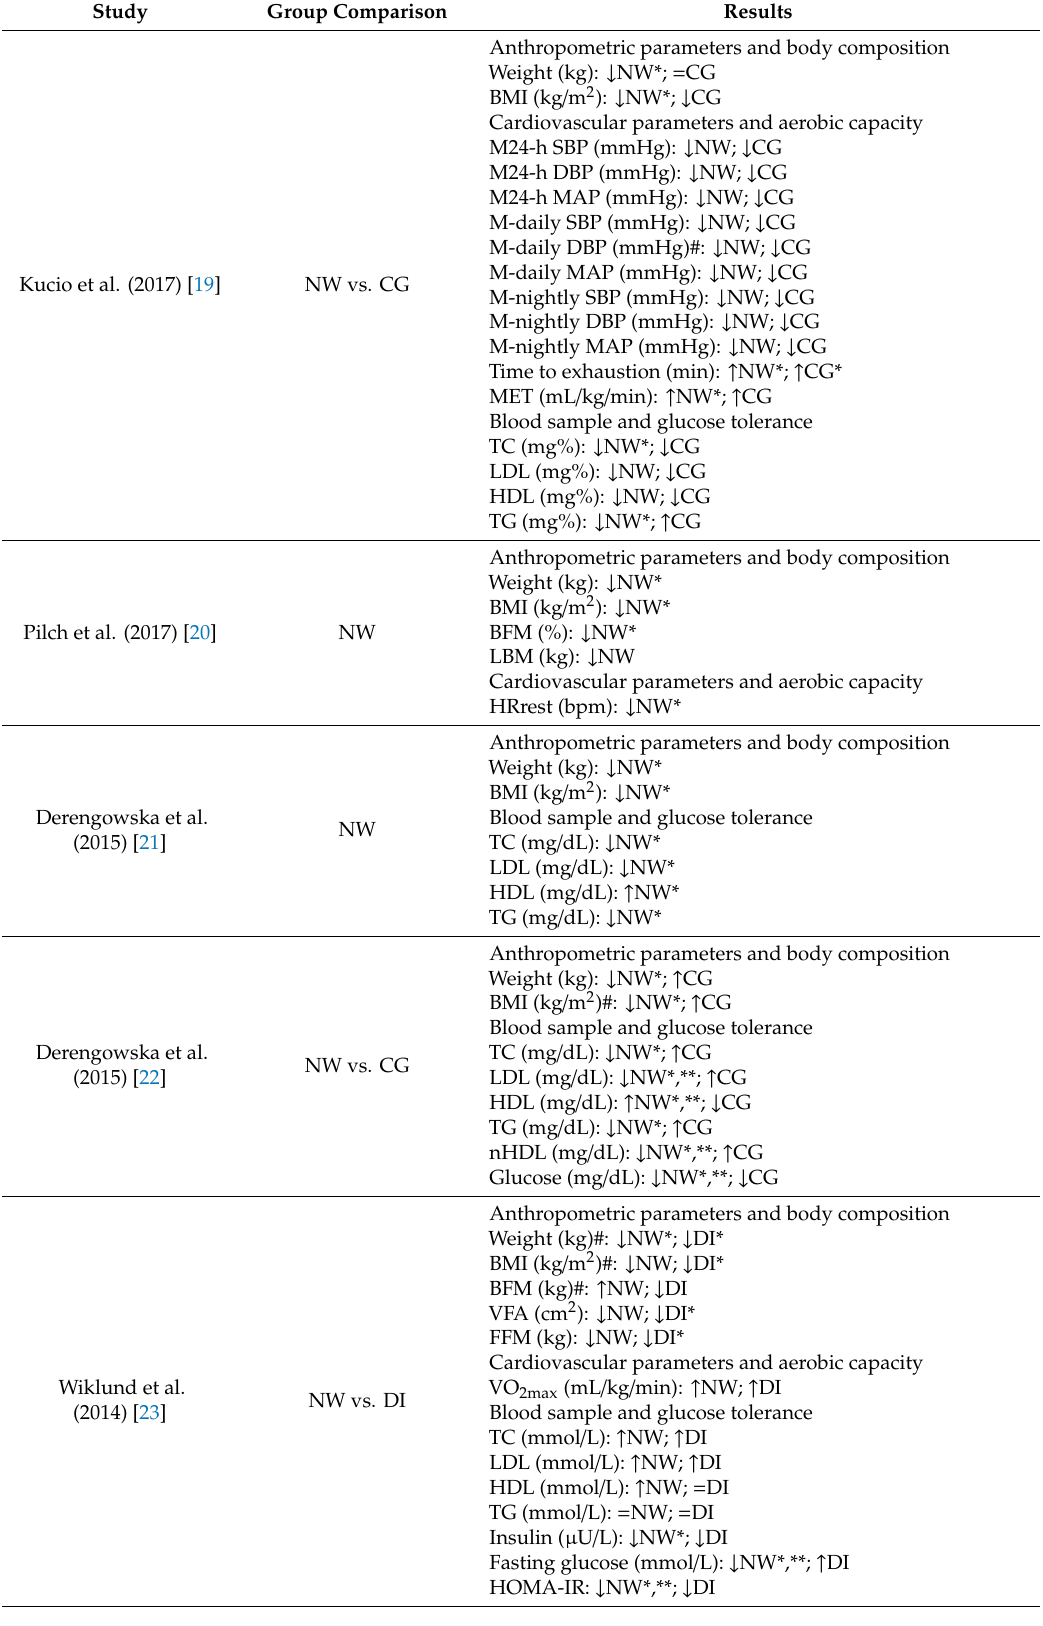
Table 3. Results of the included